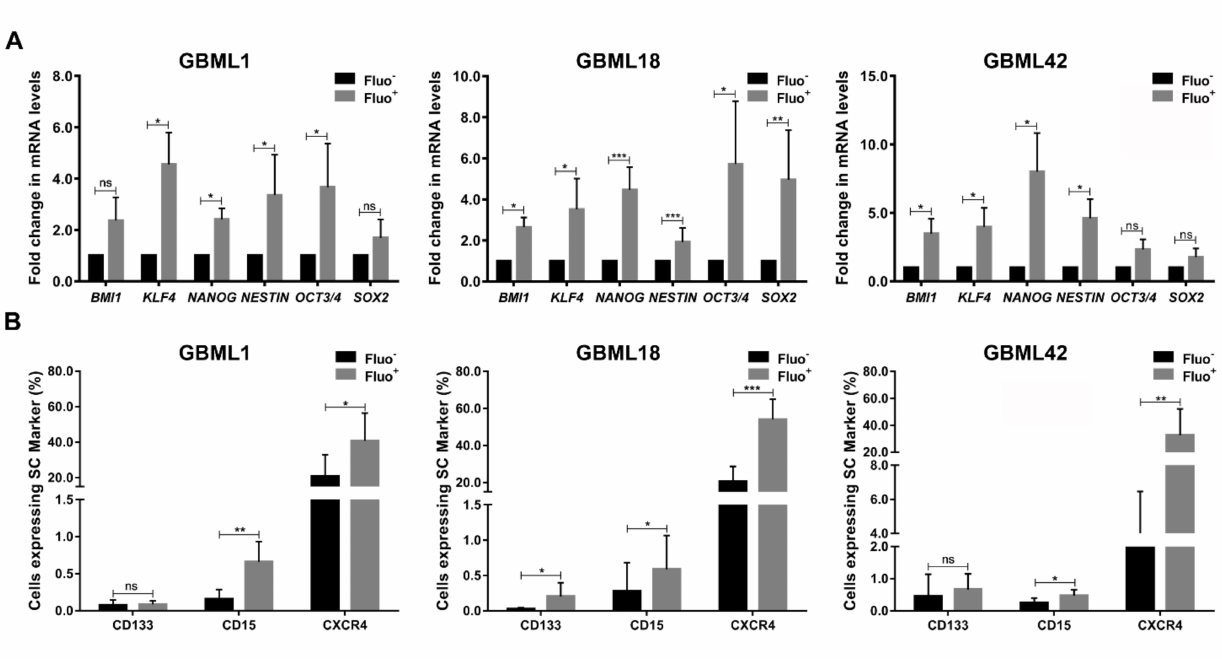
Figure 2. Autofluorescent GBM cells have increased expression of stemness- and pluripotency-associated markers. ( A ) RT– qPCR analyses of pluripotency-associated genes ( BMI1 , KLF4 , NANOG , NESTIN , OCT3/4 and SOX2 ) in fluorescence activated cell sorting (FACS)–sorted Fluo − and Fluo + cells from human primary GBM cultures, GBML1, GBML18 and GBML42. Data shown are normalized for TBP expression and represent the fold change between Fluo + vs. Fluo − cells. ( B ) Quantification of flow cytometry analyses for the indicated cell surface stem cell protein markers (CD133, CD15, and CXCR4) in human primary GBM cultures, GBML1, GBML18 and GBML42. Data are represented as the mean ± SD of at least three independent experiments (* p ≤ 0.05, ** p ≤ 0.01, *** p ≤